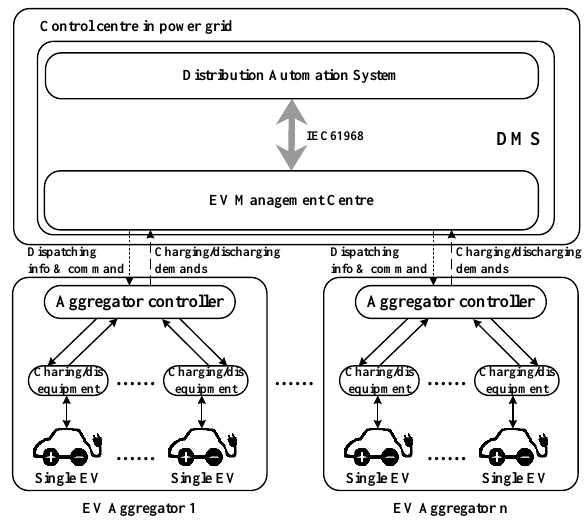
Figure 1. Framework of the electric vehicles (EVs) charging management system.